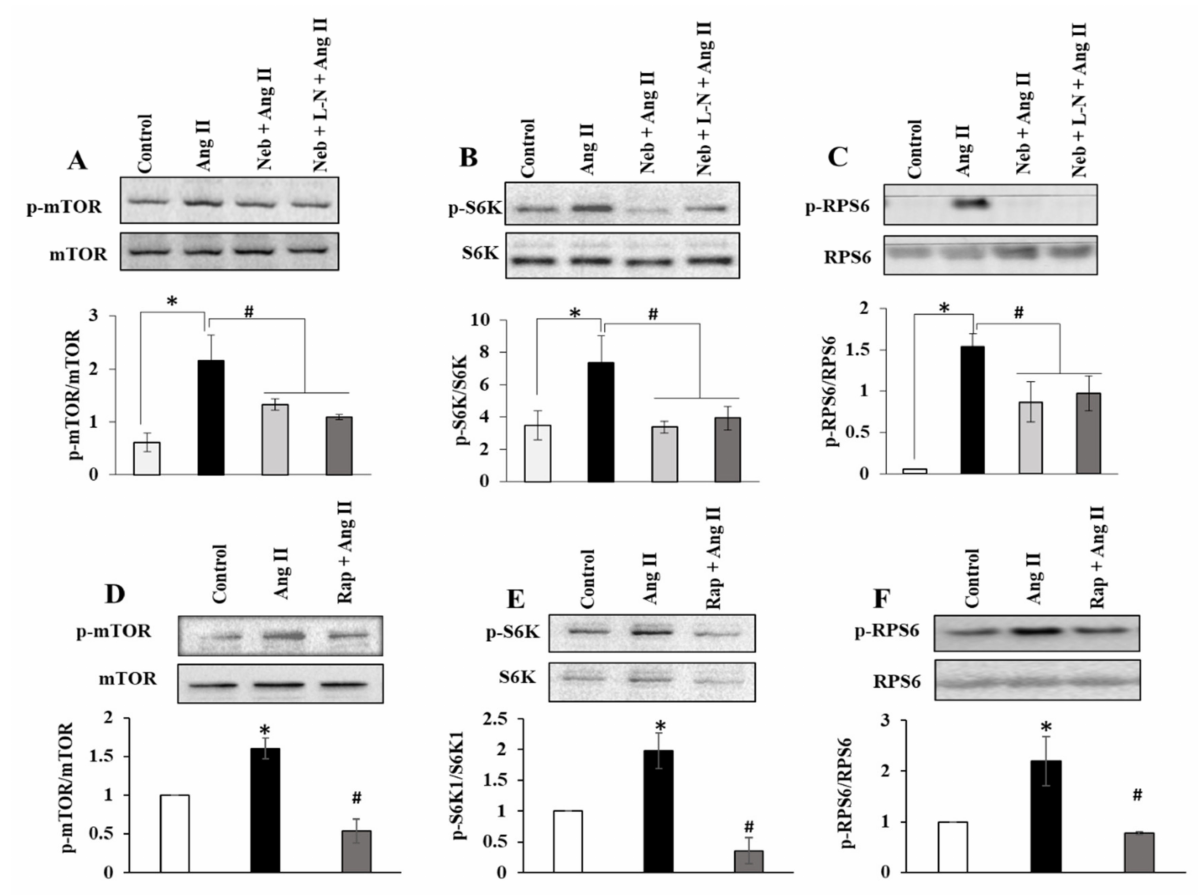
Figure 3. Effects of Neb plus L-N combination on Ang II-induced mTOR signaling in H9c2 cardiomy- oblasts. Top: Representative images of autoradiograms showing elevated levels of pSer2448 mTOR ( A ), pThr389 S6K1 ( B ), and pSer235/236RPS6 ( C ) in H9c2 cardiomyoblasts stimulated with Ang II and suppression by Neb and Neb + L-N. Bottom: Graphs show results of densitometry analysis of the intensity of the phosphorylated protein bands after adjusting for the intensity of total protein bands (tmTOR, tS6K1, tRPS6). Top: Representative images of autoradiograms showing elevated levels of pSer2448 mTOR ( D ), pThr389 S6K1 ( E ), and pSer235/236RPS6 ( F ) in H9c2 cardiomyoblasts stimulated with Ang II and suppression by Rap. Bottom: Graphs show results of densitometry analysis of the intensity of the phosphorylated protein bands after adjusting for the intensity of total protein bands (tmTOR, tS6K1, tRPS6). * p < 0.05 vs. untreated (Con) and # p < 0.05 vs. Ang II. Values are means ± SEM. N ≥ 3–6 for each treatment